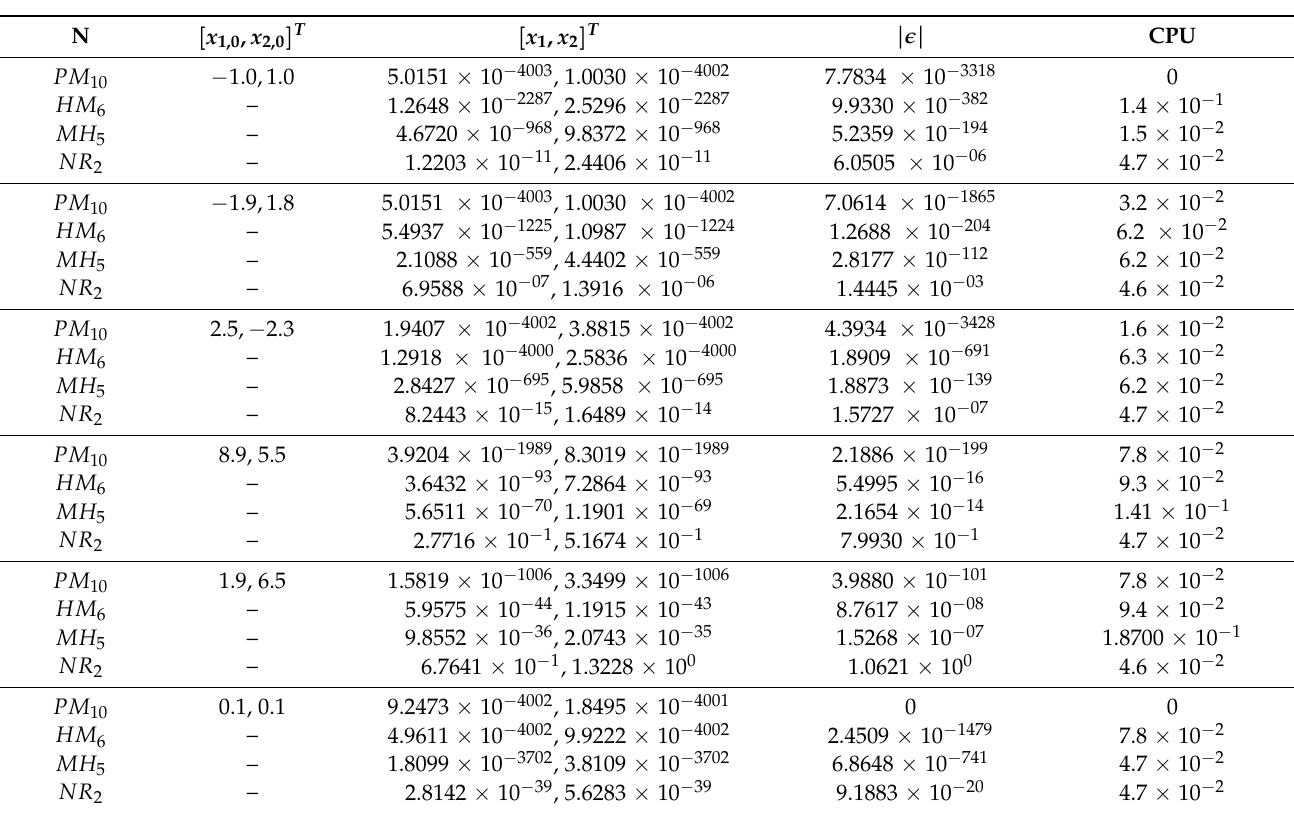
Table 12. Numerical results for problem